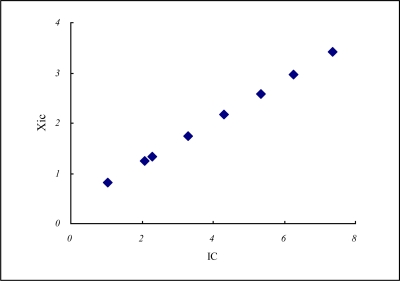
IC vs. XIC for hydrogen and the top elements indicated in Table 2.